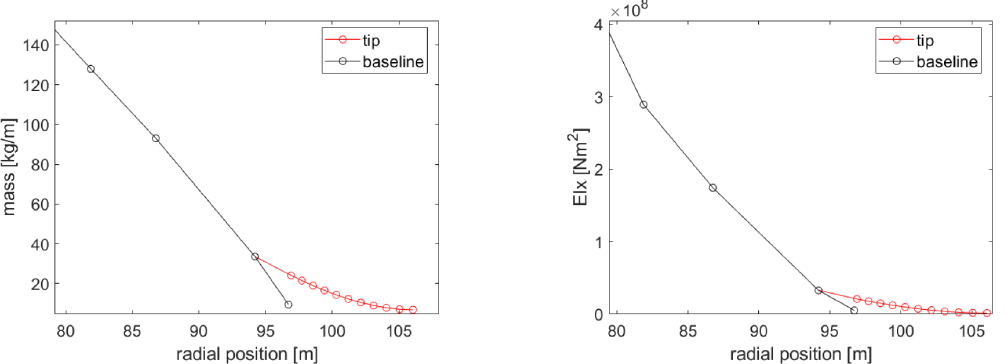
Figure 11. Mass and flapwise stiffness of the optimized design (zoom-in of the tip). Table 3. Comparison of AEP predictions for the baseline and optimized designs between HAWC2-NW and HAWC2-MIRAS.